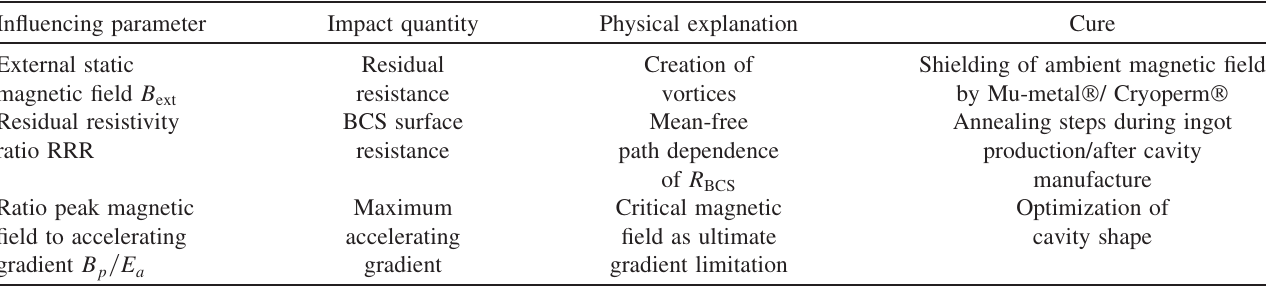
TABLE VIII. Several additional deterministic parameters other than R s , f , T , (cid:4) , (cid:5) , r K . Influencing